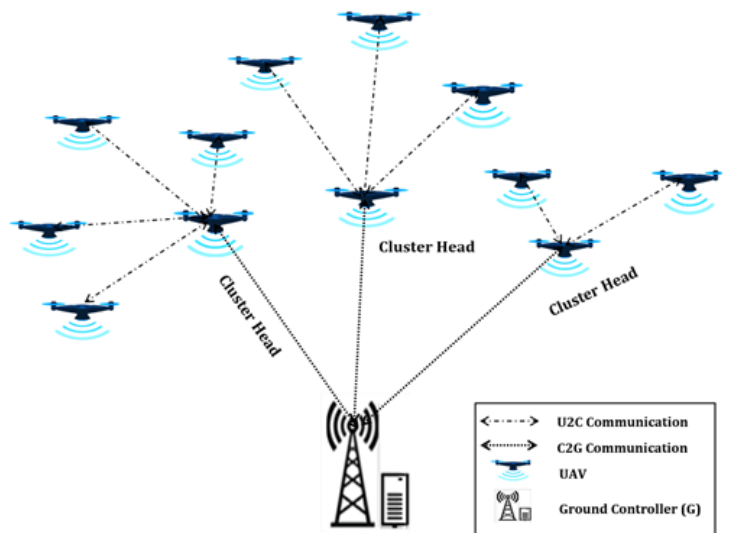
Figure 2. Multiple cluster interactive